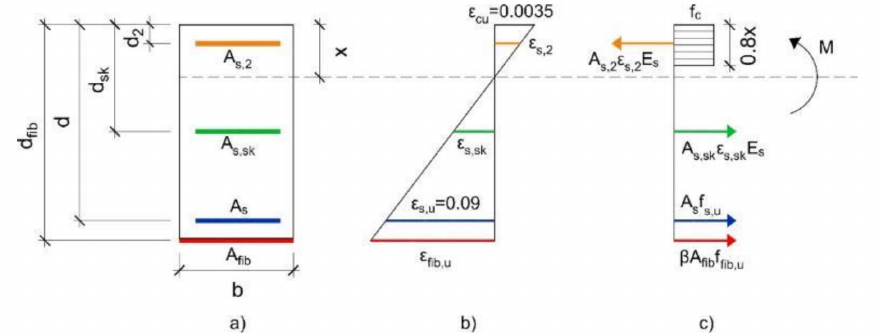
Figure 3. Analysis of the cross-section for the ultimate limit state in bending: ( a ) Geometry, ( b ) strain distribution, and ( c ) force